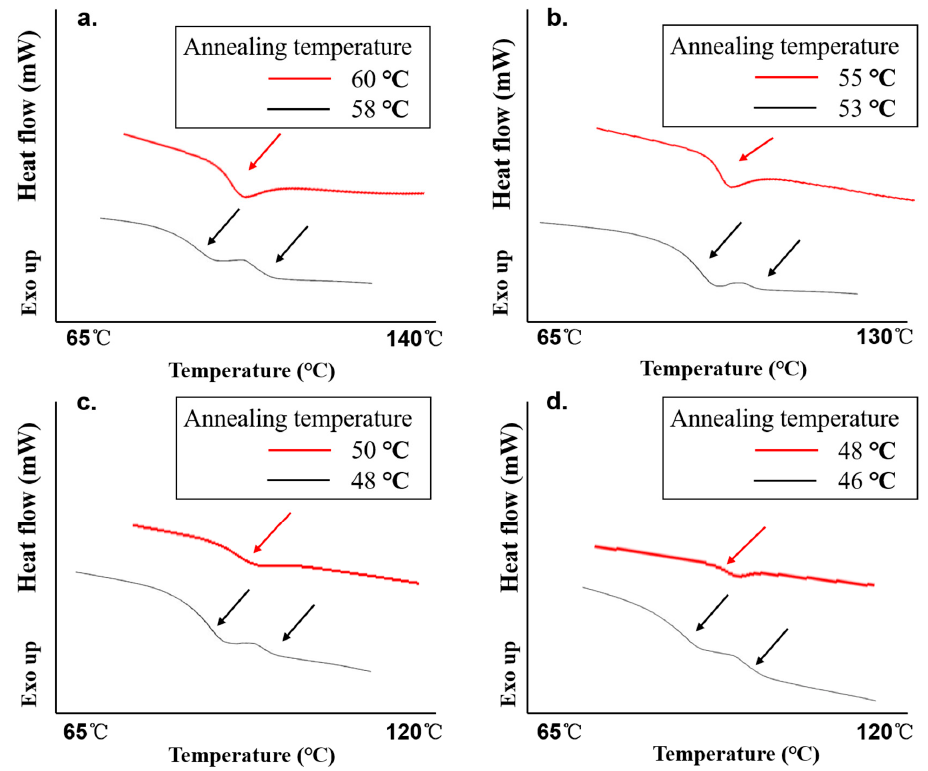
Figure 5. The thermograms of FD-PVPK15 ASDs at drug loading. ( a ) 35% drug loading; ( b ) 40% drug loading; ( c ) 45% drug loading; ( d ) 50% drug loading; the red lines represent the ASDs after annealed at the conditions above the binodal curve, and black lines represent the dried ASDs after annealed at conditions below the binodal curve (Table 2).